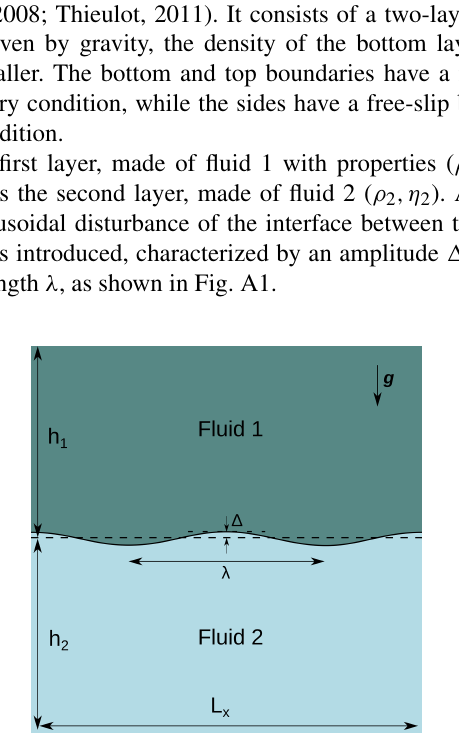
Figure A1. Rayleigh–Taylor instability benchmark initial setup.